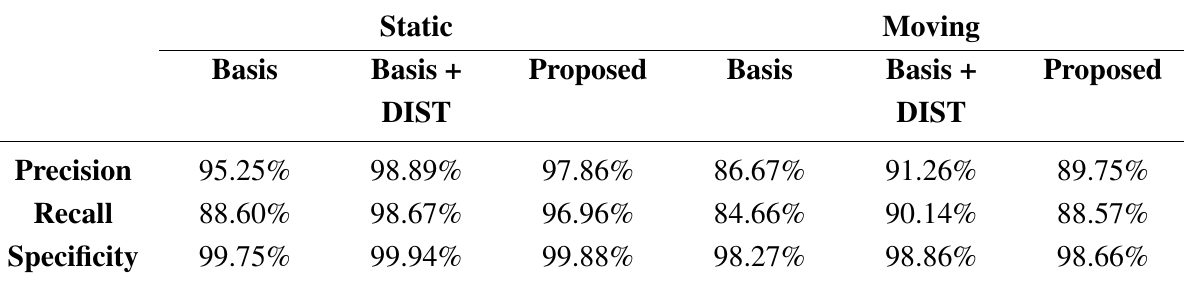
Table 2. Results comparison of laser feature sets. Three feature sets are compared. The feature basis is described in Table 1. DIST denotes the addition of distance features to the feature basis. The proposed feature set is described in Section 4.2. The laser data sets from Table 3 were